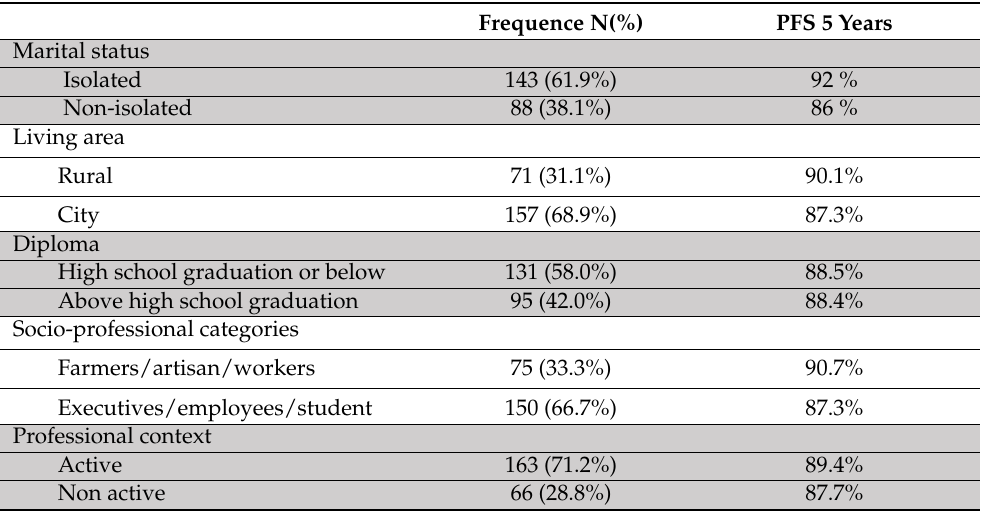
Table 2. Survey response and progression-free survival after 5 years according to the sociodemo- graphic characteristics of patients who completed the